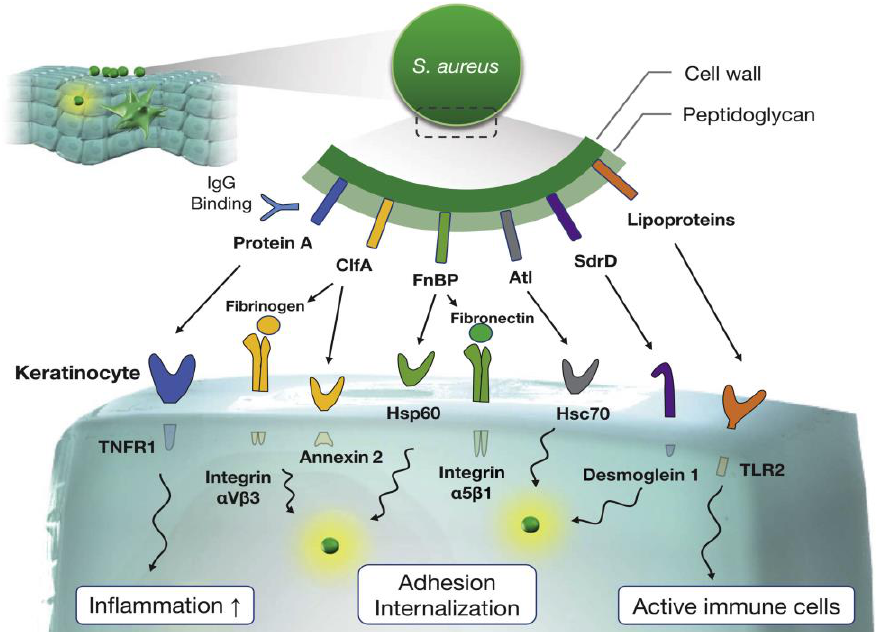
Figure 1. Interactions between SA cell wall proteins and keratinocytes. Cell wall proteins, clumping factor A (ClfA), fibronectin-binding proteins (FnBP), autolysin (Atl), and serine aspartate repeat- containing protein D(SdrD) involved in adhesion and keratinocyte internalization via respective receptors (heat shock protein 60 (Hsp69), Integrinα5β1, Annexin2, with fibronectin bridging, Desmoglein1, and Heat shock cognate 71 kDa protein (Hsc70)). In addition, PA induces inflammation by binding to tumor necrosis factor receptor-1 (TNFR1), and Toll-like receptor 2 (TLR2) senses lipoprotein following the activation of immune cells. Reproduced with permission from Elsevier [59].